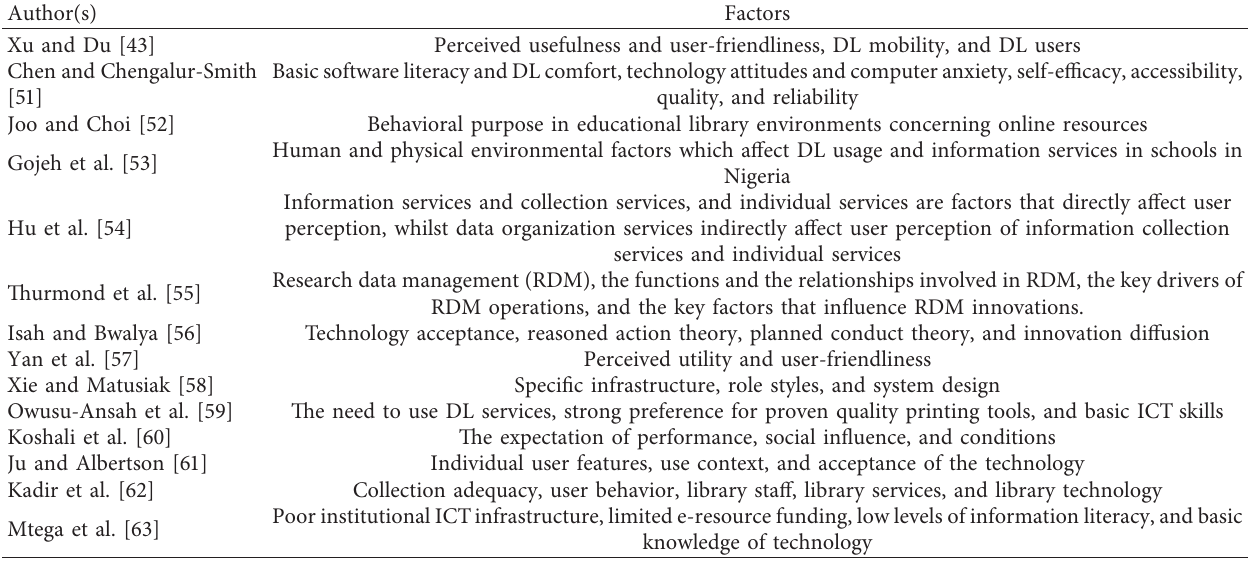
Table 1: A summary of the essential variables related to digital library adoption and